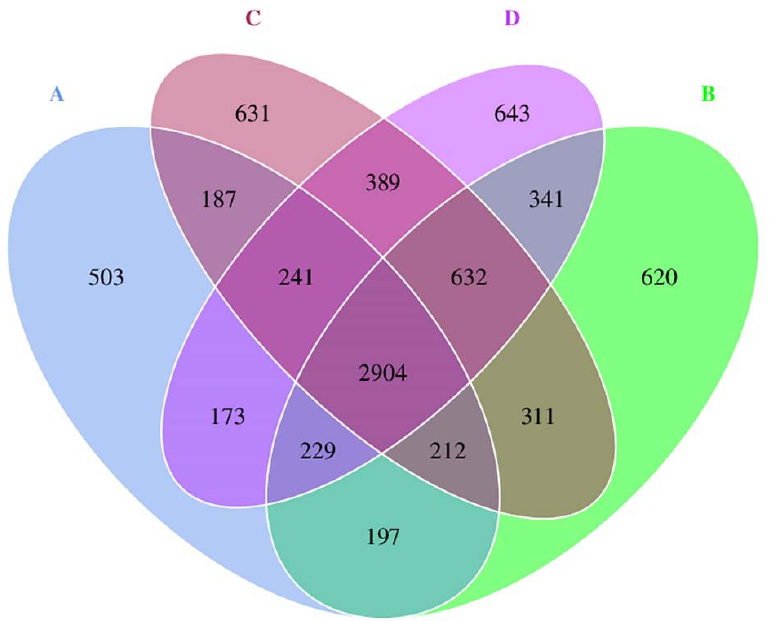
Figure 1. Venn diagram presenting the numbers of overlapping, unique, and shared OTUs among treatments. Treatment A, an uninoculated control; B, inoculation with Paenibacillus sp. strain OL15 immobilized in agar; C, inoculation with Paenibacillus sp. strain OL15 immobilized in alginate; D, inoculation with a cell suspension of Paenibacillus sp. strain OL15. Table 5. Bacterial diversity and richness of the waste lubricating oil-contaminated soil from each treatment.